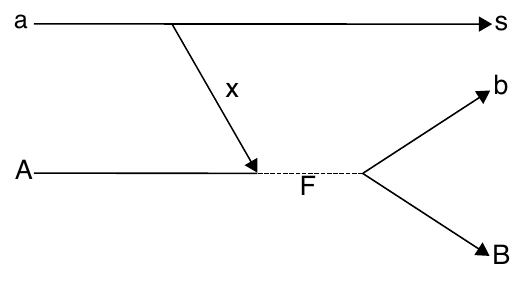
Figure 1. Sketch of the participant ( x )-spectator ( s ) mechanism leading to the population of excited states of the intermediate nucleus F , necessary condition for the application of the THM